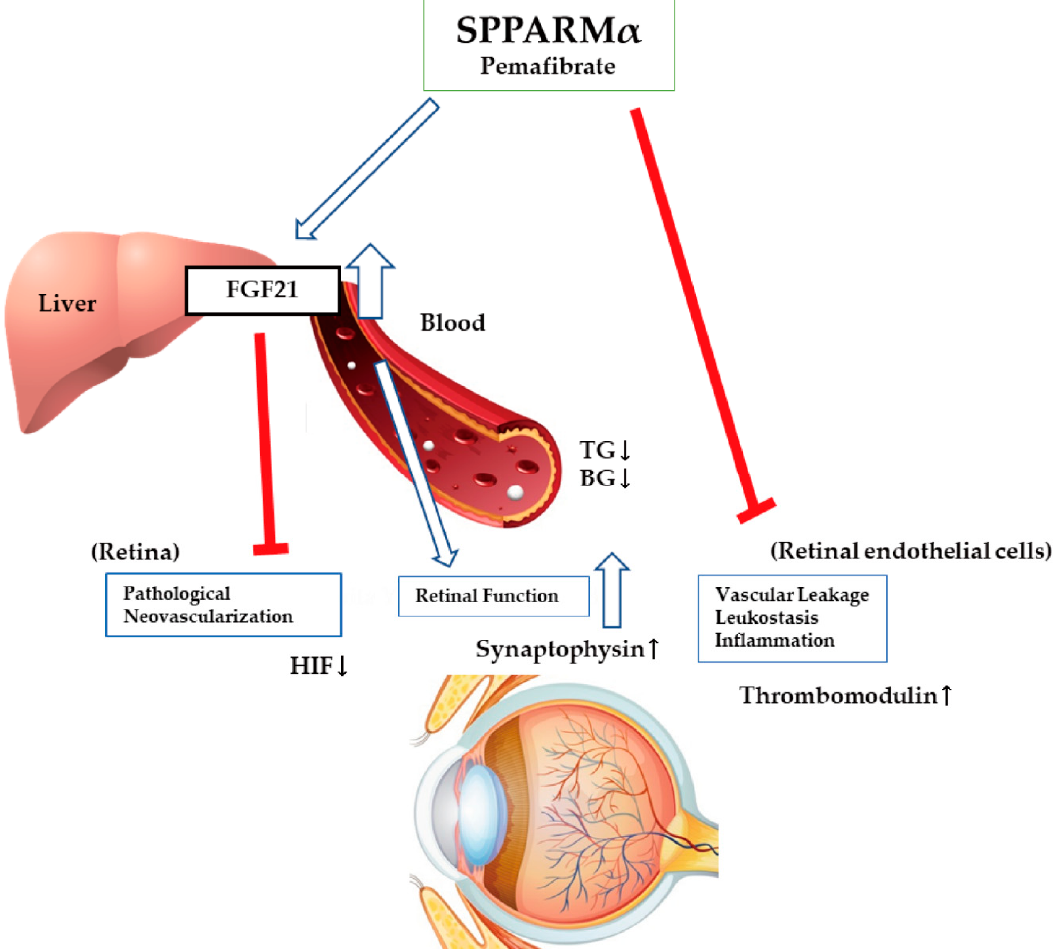
Figure 3. A schematic model of protective effects of a selective peroxisome proliferator-activated receptor alpha modulator (SPPARM α ), pemafibrate, on injured retinas. Two therapeutic pathways are suggested. One is that pemafibrate upregulates fibroblast growth factor (FGF) 21 expression in the liver or blood and affects the retina or modulates abnormal metabolisms such as the reduction of increased serum triglyceride and blood glucose levels. The other way is pamafibrate directly affects retinal endothelial cells with vascular leakage, leukostasis, and inflammation. HIF; hypoxia-inducible factor, TG; triglyceride, BG; blood glucose. Inhibition of an event: red lines; Stimulation of an event: white lines with blue line borders.